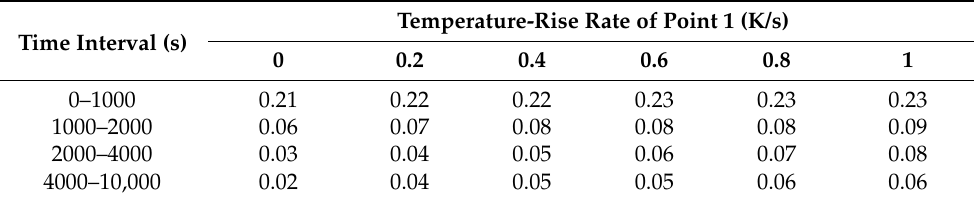
Table 11. Temperature-rise rate with different intra-pore emissivity at different times.